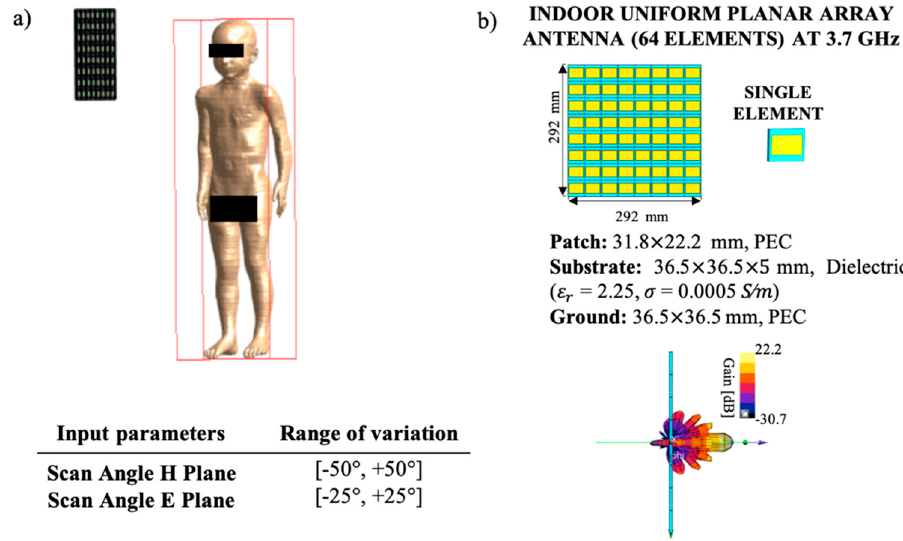
Figure 1. ( a ) Exposure scenario and the two input parameters for the beamforming pattern with their ranges; ( b ) details and gain diagram of the uniform planar array (UPA) antenna with 64 elements at 3.7 GHz.